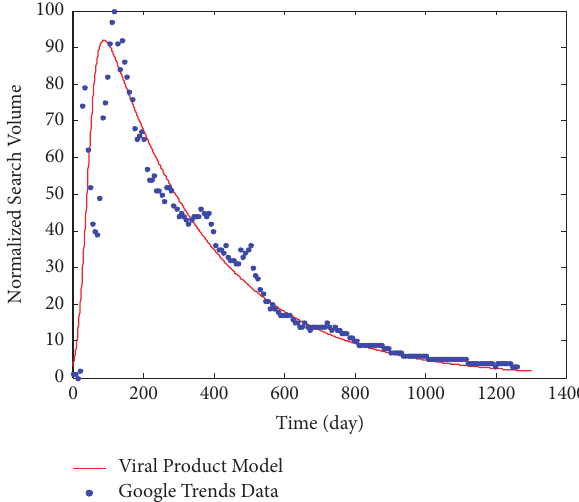
Figure 3: Model fitting on “Nokia Lumia 920” from August 2012 to January